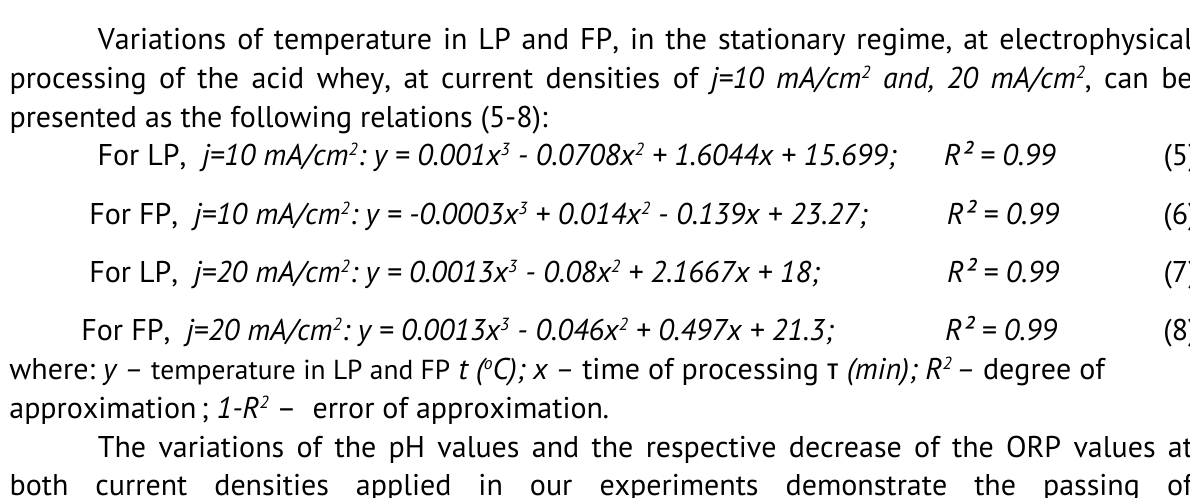
Figure 4. Temperature variations in LP and FP, at j = 10 mA·cm -2 .